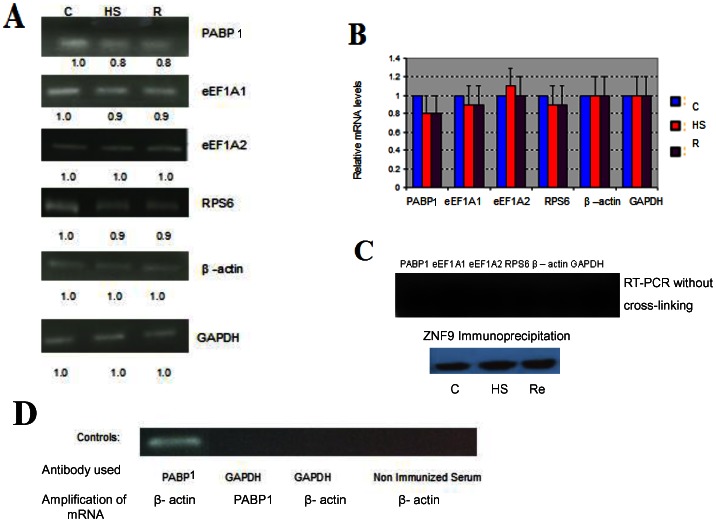
Immunoprecipitation of RNA-ZNF9 Complex.A) HeLa cells were grown to 40% confluence; heat shocked for 3 hours at 44°C, and allowed to recover at 37°C for 24 hours. Cellular RNA and proteins were cross-linked with formaldehyde and lysed as described in materials and methods. Cell lysates were subjected to immunoprecipitation of RNA-ZNF9 complexes as described in the methods section. RNA from the immunoprecipitates was isolated and reverse-transcribed using random primers followed by PCR amplification using mRNA specific primers. PCR products were analyzed by electrophoresis in a 1% agarose gel and quantified by scanning as described in materials and methods. The levels of different mRNAs were normalized to the level of β-actin mRNA and expressed in arbitrary units below each lane. B) Each set of experiments was repeated three times, and the averages are shown here as mean ± standard error. C) First row; as a negative control immunoprecipitation of non cross-linked cell extract of exponentially growing HeLa cells was performed with ZNF9 antibody and RNA was extracted and used for RT-PCR as described in materials and methods. The results of analyses of RT-PCR products by 1% agarose gel electrophoresis with different mRNA specific primers are shown. The bottom row shows the results of western blotting experiment of immunoprecipitated samples prior to RNA isolation from the lysate of cross- linked control (C), heat shocked (HS) and recovered cells (Re). D) Exponentially growing HeLa cells were subjected to cross-linking as described above and the cell lysate was treated with either, non-immunized serum or GAPDH or PABP1 antibody and the RNA was extracted from the immunoprecipitates. The RNA samples were analyzed for the presence of either PABP1 or β-actin mRNA as described before.